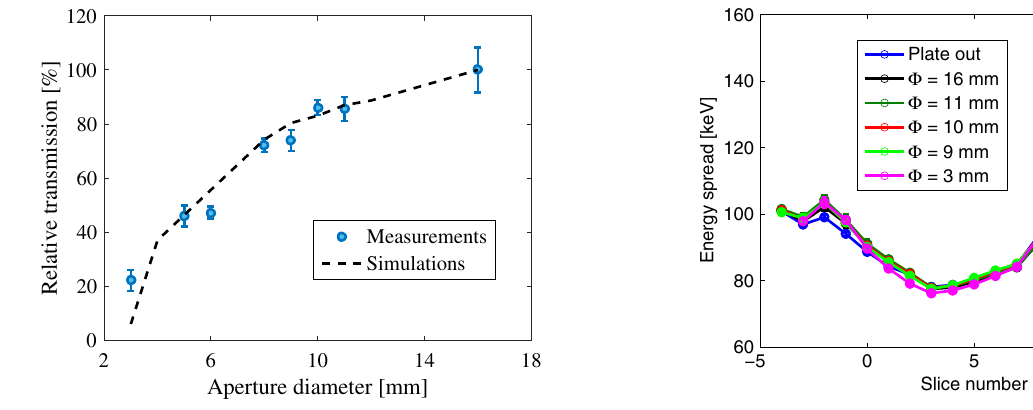
FIG. 19. Measured field emitted charge at the end of SITF as a function of the collimator aperture compared with the simula- tions. Each integrated current is normalized to the transmitted charge with the largest collimator aperture (16 mm).